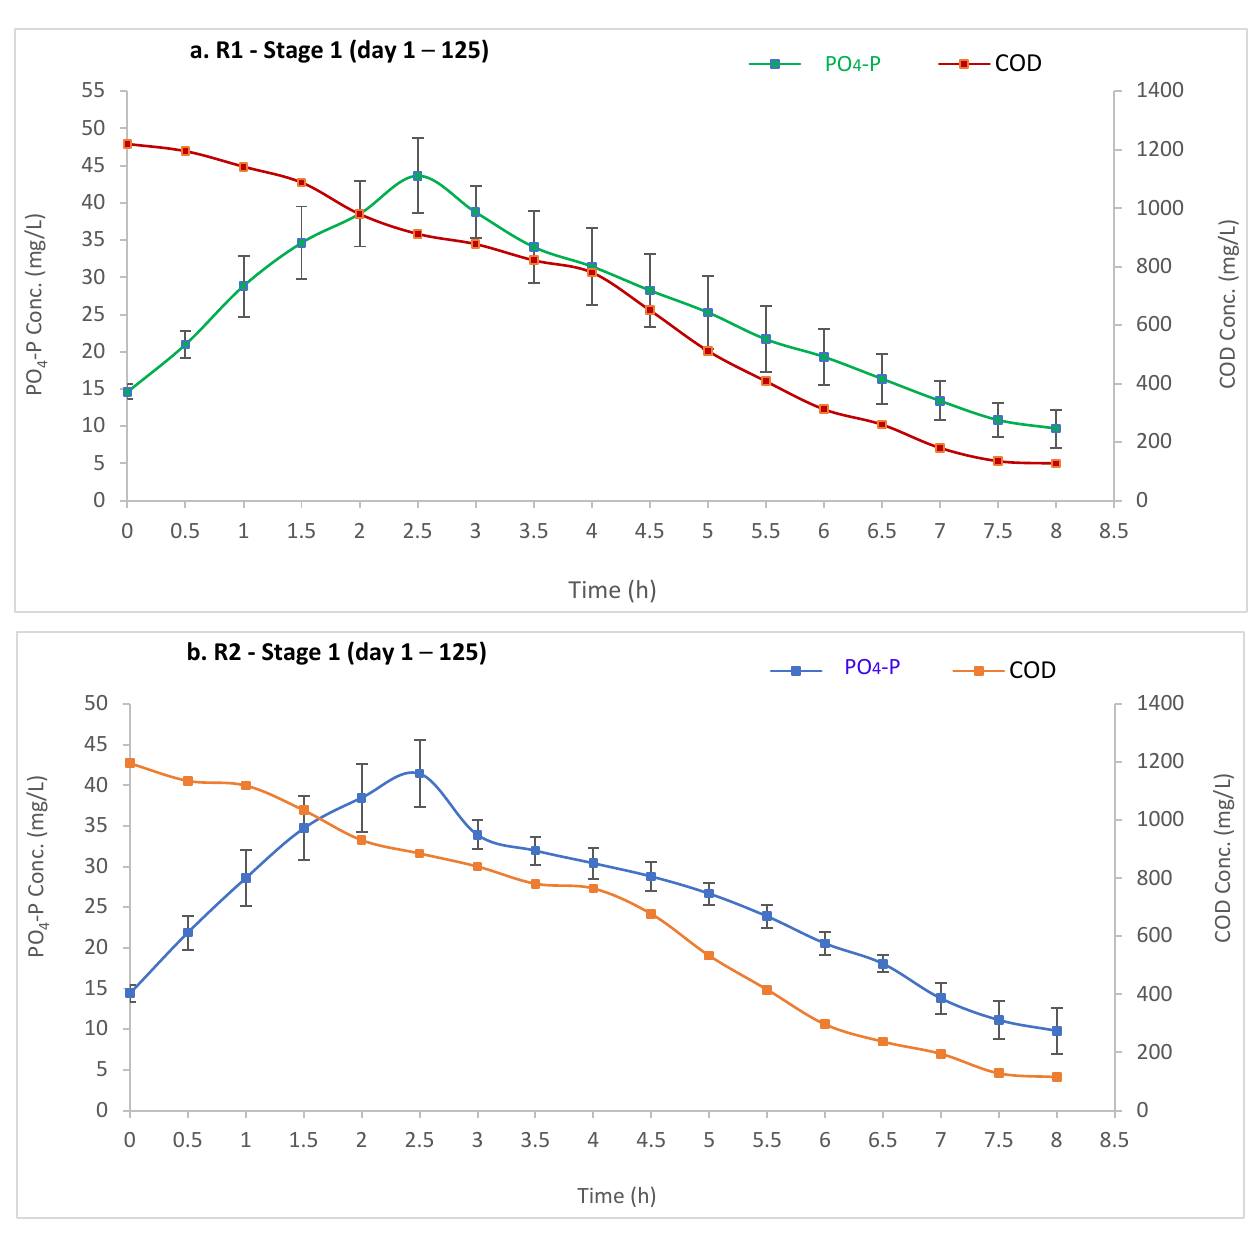
Figure 5. Phosphorus and COD removal through a typical cycle during stage I in ( a ) R1 and ( b ) R2. Till day 175 of operation (maturation stage), and under the same influent characteristics (high OLR and COD:TN:TP) and same operational design parameters (time of cycle’s stages, HRT, superficial air velocity), relatively higher phosphorus removal efficiencies for R1 and R2 were observed compared to the previous cultivation stage. Variation in the phosphorus removal of R1 and R2 was observed, and the mean phosphorus removal efficiencies for R1 and R2 were 75.6 ± 5.9% and 74.5 ± 9.6%, respectively. In addition, the variance in the removal efficiency of PO 4 -P concentrations for the GSBRs was observed and concentrations as high as 7.6 mg/L and 7 mg/L were recorded for R1 and R2, respectively, at the beginning of maturation period (day 140). Moreover, after day 220 until the end of this period (day 300), phosphorus concentrations in the effluents of both reactors were between 2–3 mg/L. As mentioned previously, the size of the aerobic formed granules in both reactors increased from 2.1 mm (by the end of cultivation stage) to more than 3 mm during this stage. Consequently, the mechanisms for phosphorus removal in these GSBRs systems have improved during this stage due to the impact of enhanced biological phosphorus removal (EBPR), which depends on the enrichment of PAOs in the GSBRs, as well as